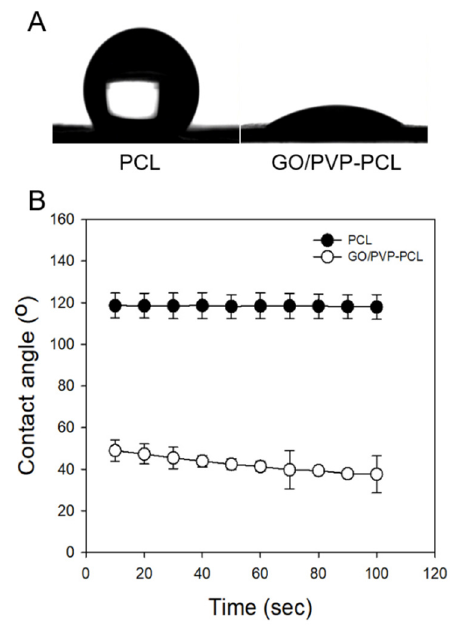
Figure 3. Water contact angle (WCA) of PCL and GO/PVP-PCL: ( A ) WCA images; ( B ) WCA graph.